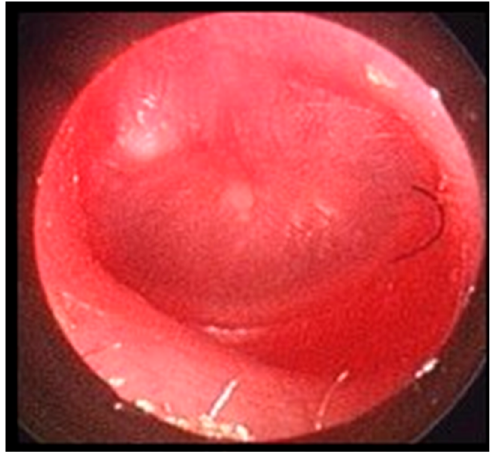
Figure 1. Tympanic membrane with intense erythema and bulging in a 2-year-old child with ear pain and fever.